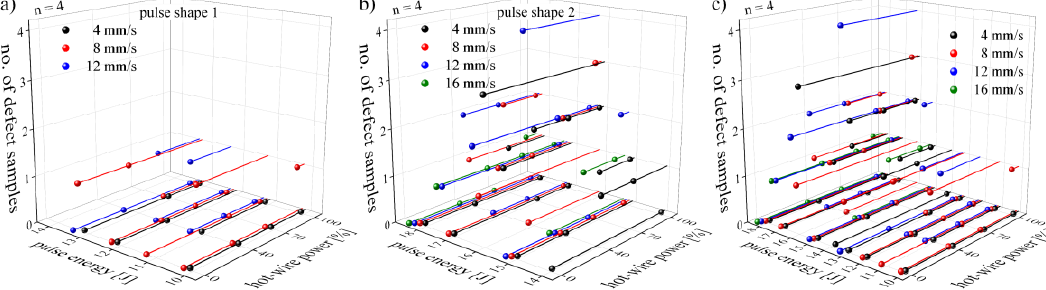
Figure 22. Number of hot-crack defected samples by random test of n = 4 as function of pulse energy and hot-wire power for pulse shape 1 ( a ), pulse shape 2 ( b ) and both together ( c ).